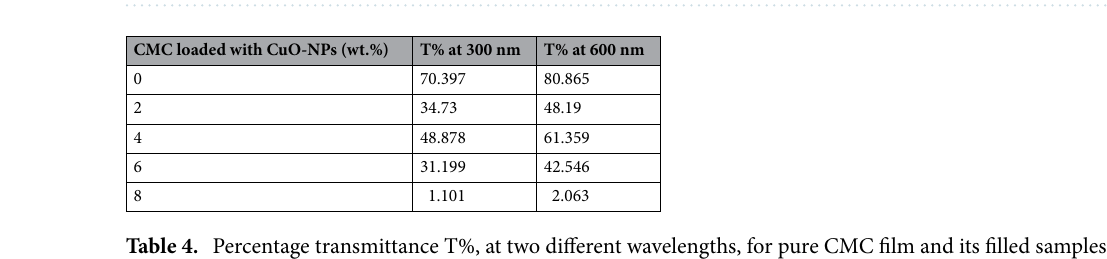
Table 4. Percentage transmittance T%, at two different wavelengths, for pure CMC film and its filled samples with different concentrations of CuO- NPs.